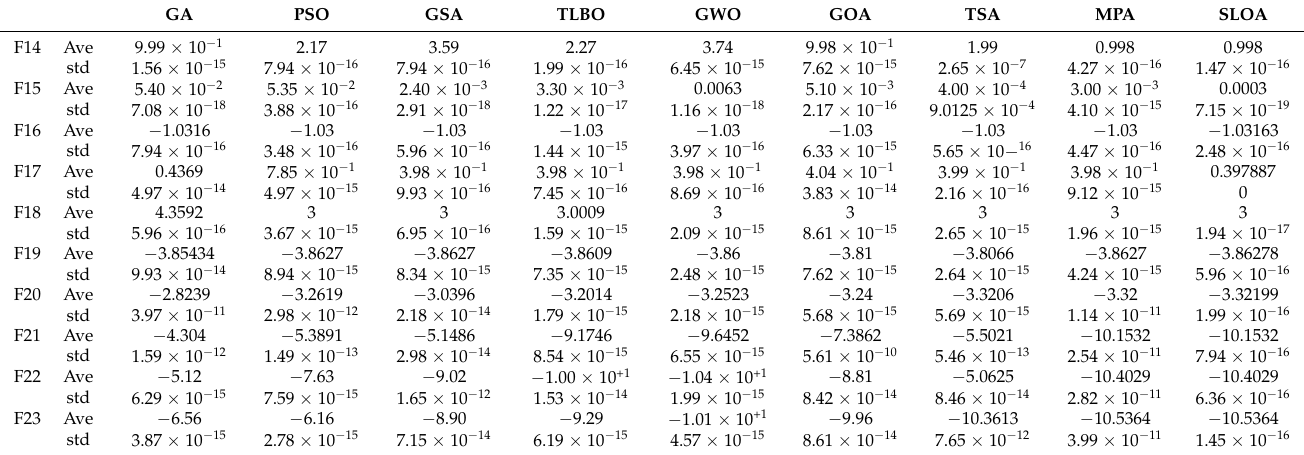
Table 4. Optimization results of SLOA and other algorithms on fixed dimensional test